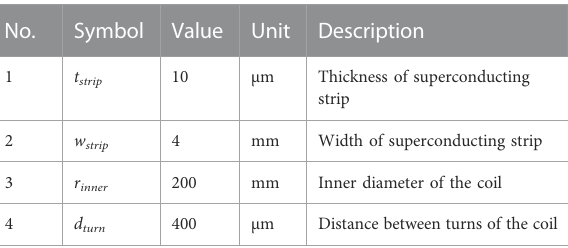
TABLE 1 Geometric parameters of pancake coil.